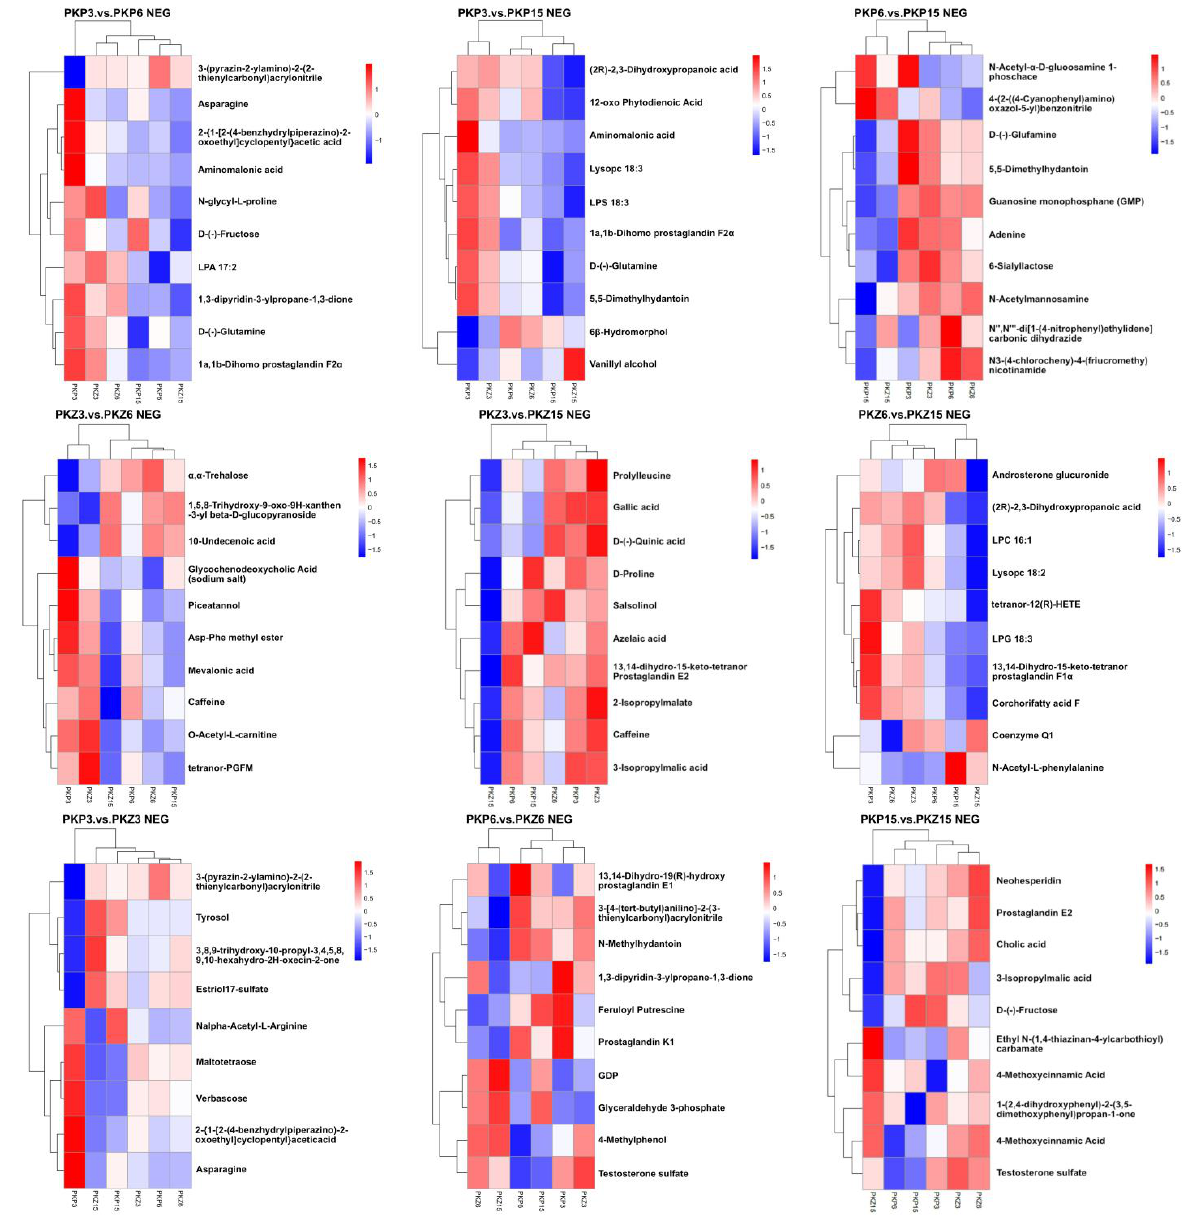
Figure 8. Hierarchical clustering results of significant differential metabolites (top 10 in each comparison group, negative ion mode). NEG: negative ion mode. PKP3–PKZ15 is the same as in Table 1.